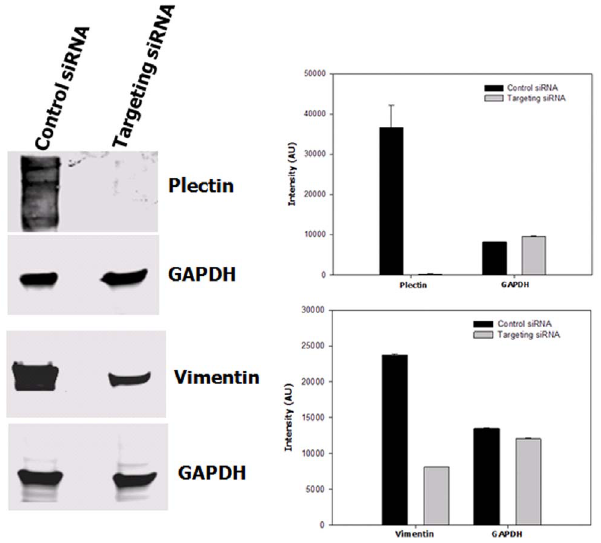
Figure 4. Validation of siRNA knockdown of plectin and vimentin in PC3-ML2 cells. Cells were treated with control siRNA, plectin or vimentin gene specific siRNA. Total cell lysates (40 m g) of ML2 cells were subjected to SDS-PAGE. The separated proteins were analyzed by Western blot analysis to detect plectin and vimentin as described. GAPDH detection was included as a loading